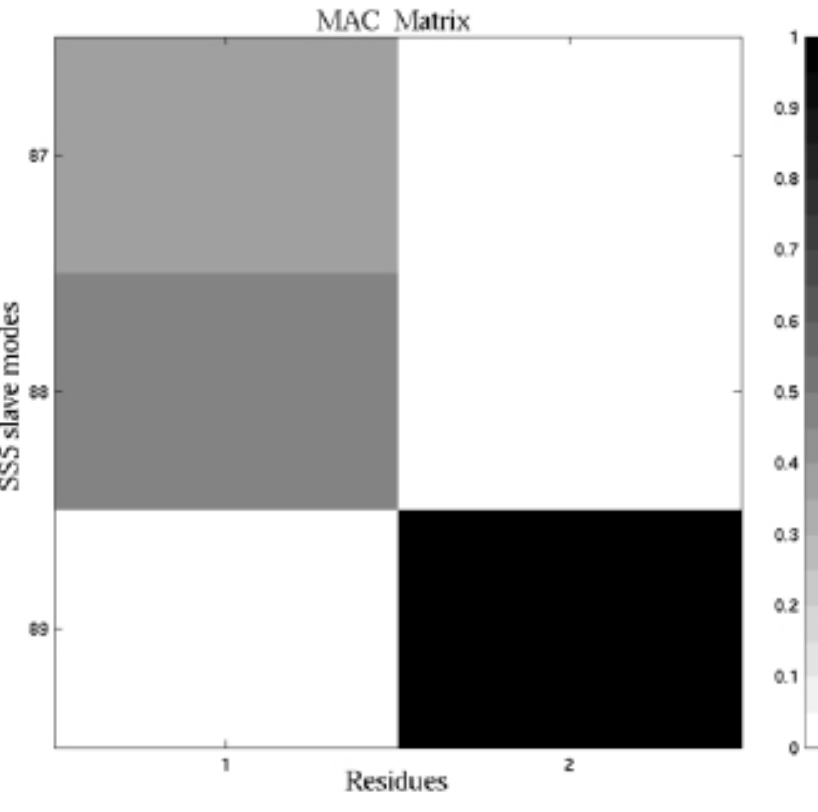
Fig. 12. Comparison between SS5 slave modes and